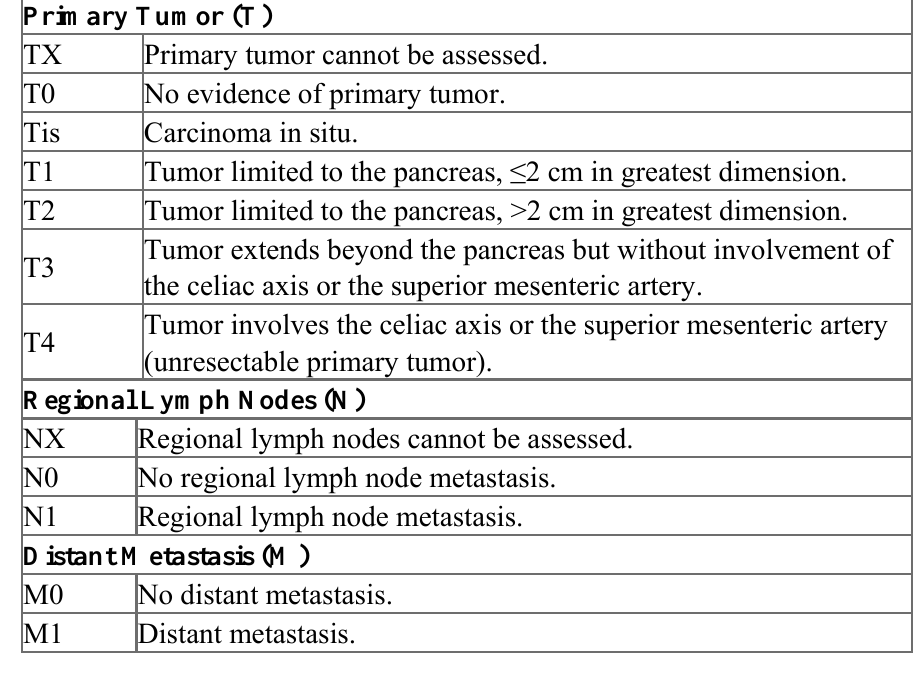
Table 1. Pancreatic cancer staging.